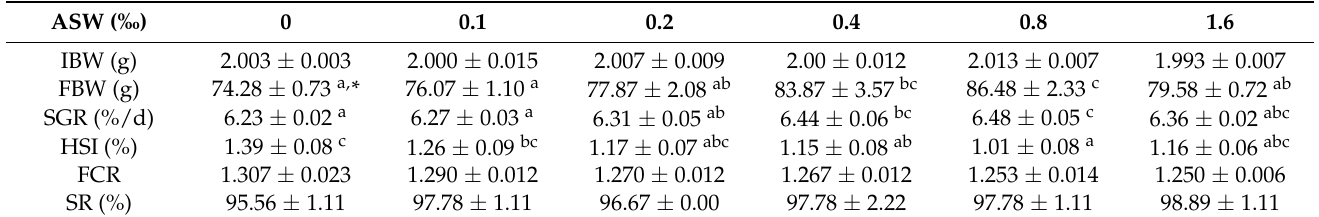
Table 3. Effect of ASW on growth performance of GIFT (mean ± SEM).